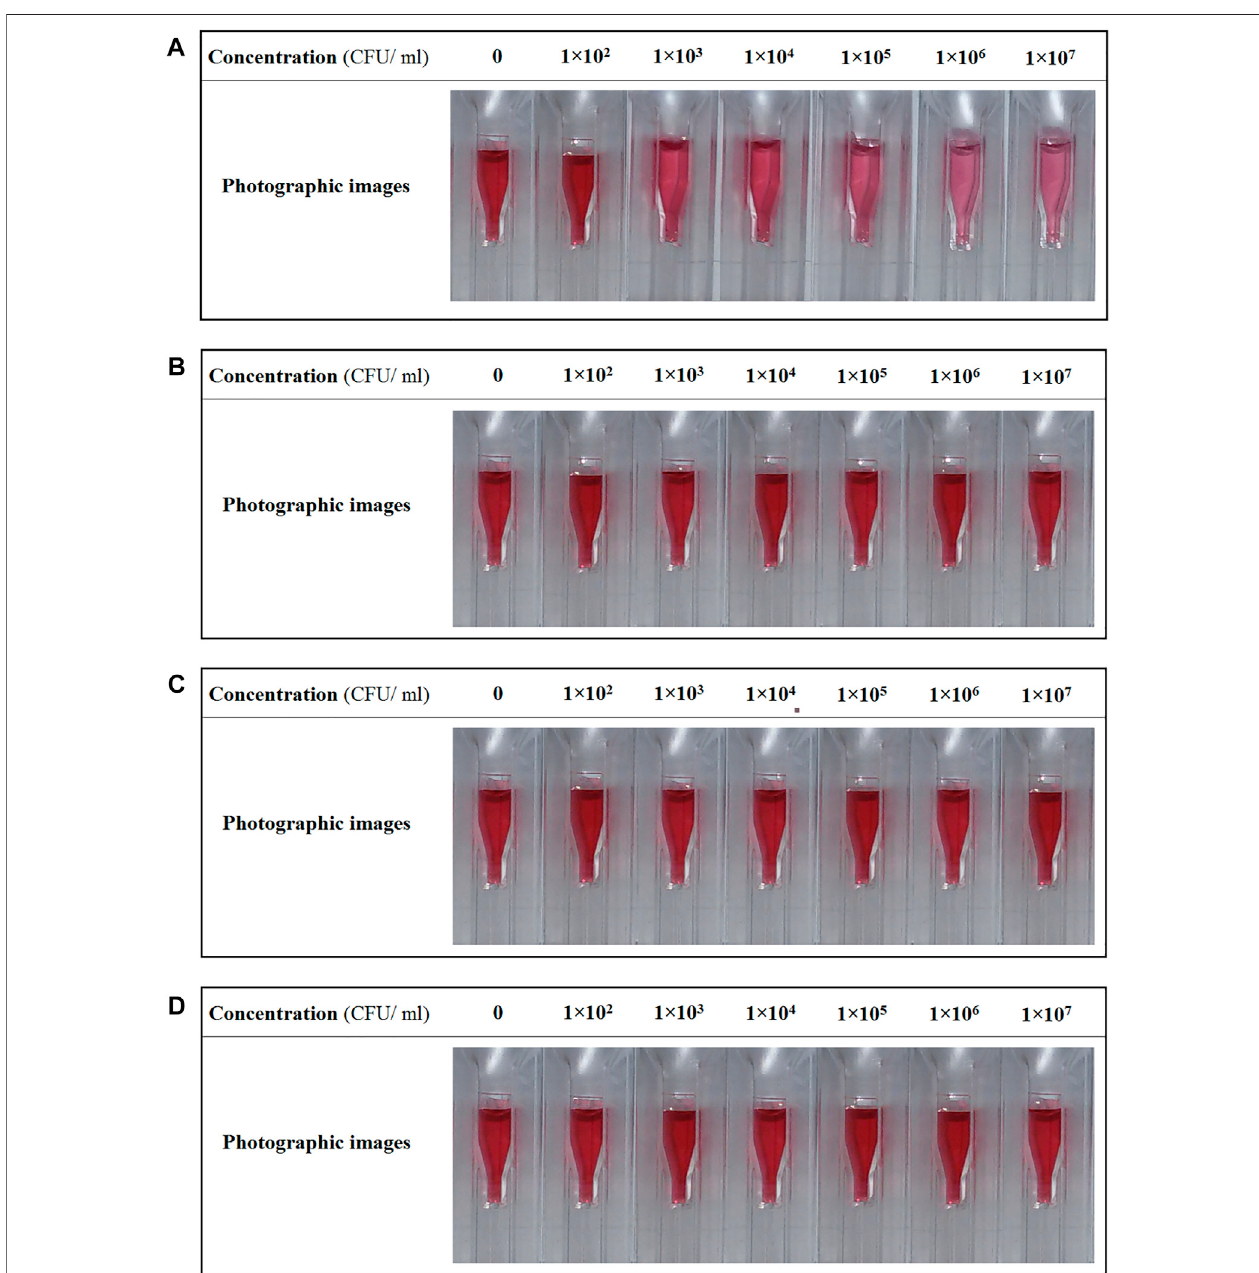
FIGURE 4 | The photographic images of H-1-AuNPs before and after adding saliva samples infected with M1 GAS (A) , M6 GAS (B) , M12 GAS (C) , and E. coli O157:H7 (D) at concentrations of 1×10 2 , 1×10 3 , 1×10 4 , 1×10 5 , 1×10 6 , and 1 × 10 7 CFU/ml. Concentration of 0 CFU/ml (as reference, H-1-AuNPs containing uninfected saliva sample). H-1-AuNPs could detect M1 GAS in a concentration range of 1 × 10 3 – 1×10 6 CFU/ml based on color changes.